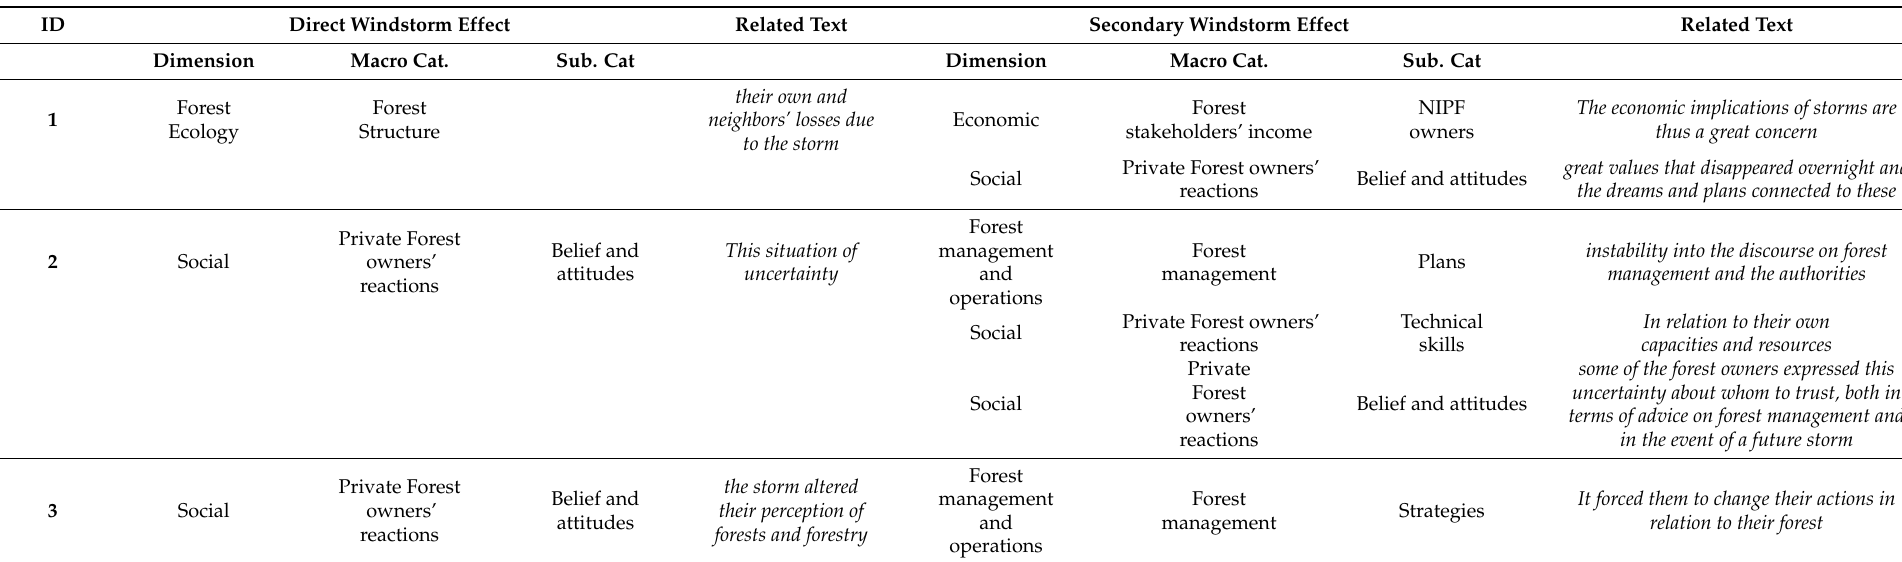
Table A3. Exemplification of coding and categorization